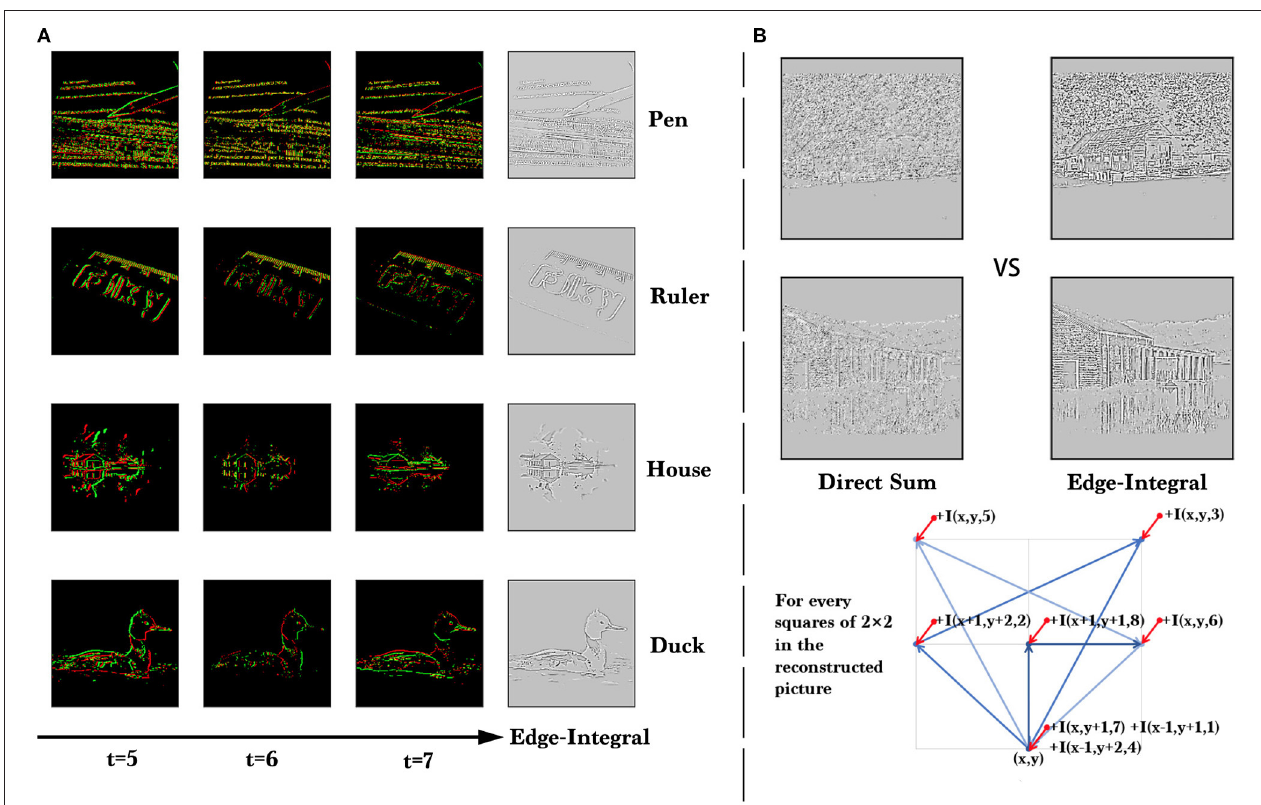
FIGURE 6 | (A) The visualization of ES-ImageNet. We show a few samples reconstructed from event streams and the event frames at the last three time steps for each sample. These examples are from four different categories and can be clearly identified. (B) Quality comparison of the reconstruction results of direct summation and Edge-Integral. Here I ( x , y , t ) means the intensity in (x,y) in the event frame at time = t